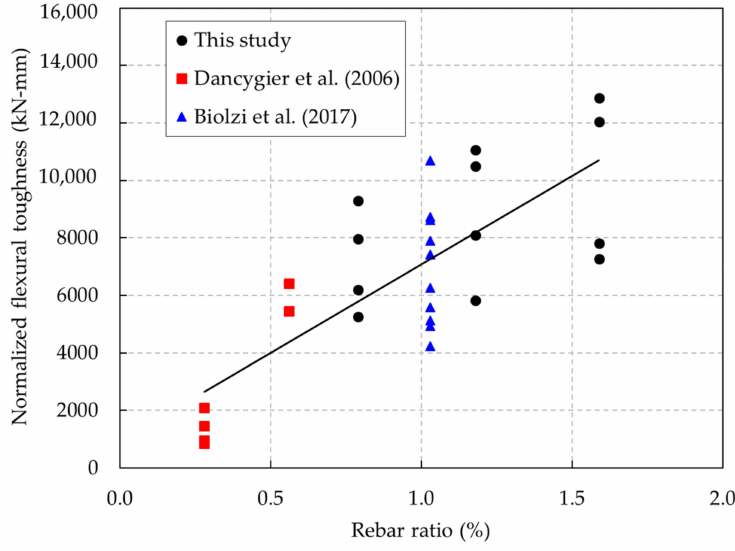
Figure 21. Comparison of the normalized toughness in this study and in previous